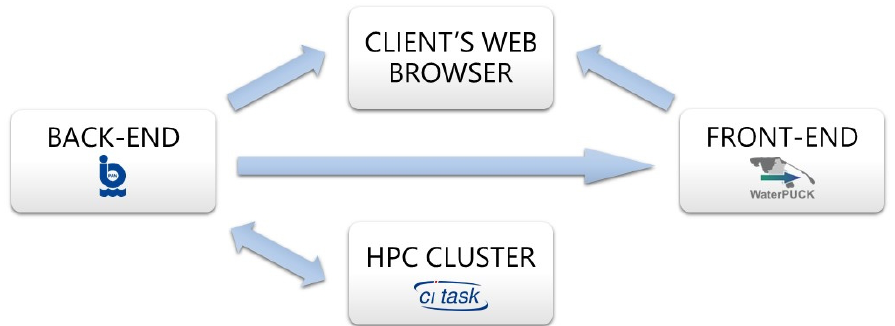
Figure 17. Architecture diagram of the WaterPUCK project’s service - the hydrodynamic part of the EcoPuckBay